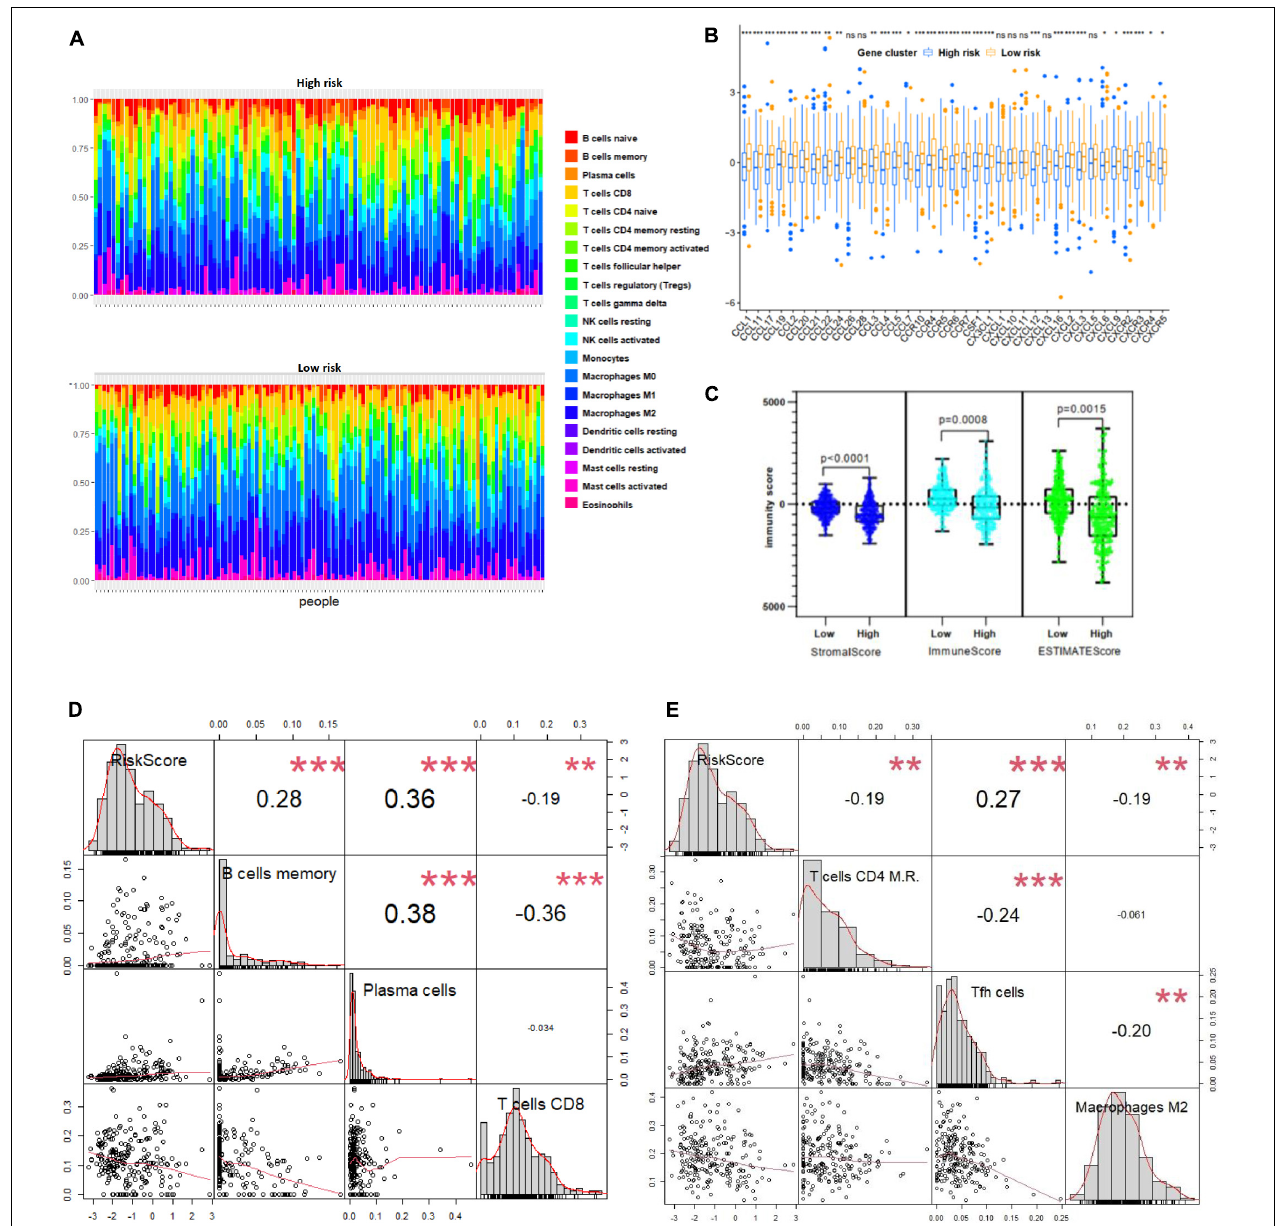
FIGURE 7 | ATG signature reflecting immune cell infiltration. (A) Heatmap shows normalized absolute abundance of 22 immune cell types in individual samples of high- and low-risk group. (B) TIP to estimate activity scores of fourth step, trafficking of immune cells to tumors. (C) Degree of stromal, immune, and estimate score in high- and low-risk group. (D,E) Relationships between RiskScore and infiltration abundances of six immune cell types including B cells memory, plasma cells, T cells CD8, T cells CD4 memory resting (here T cells CD4 M.R.), Tfh cells, and macrophages M2 ( p <